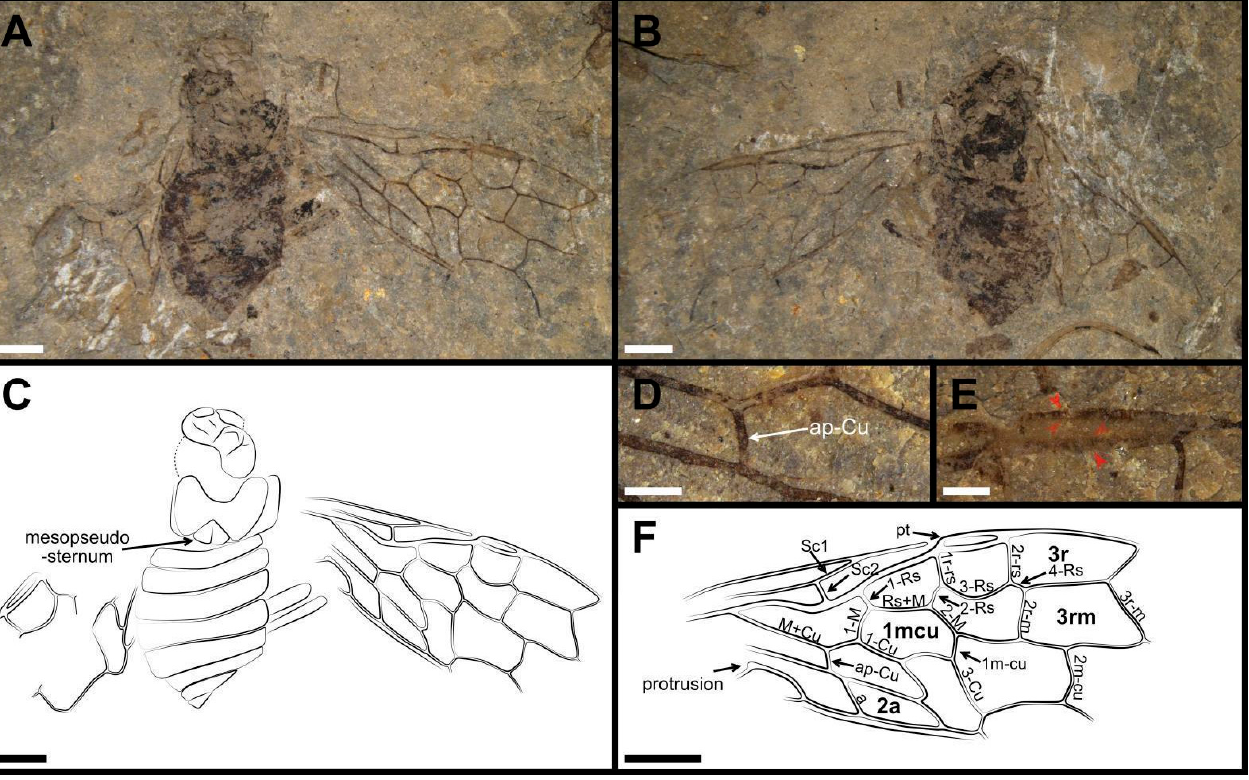
Figure 4. Dolicholyda confluens sp. nov., Holotype, (CNU-HYM-ND2022107p/c), sex unknown. ( A ), ventral view. ( B ), dorsal view. ( C ), line drawing of ventral view. ( D ), ap-Cu in forewing. ( E ), pterostigma. ( F ), line drawing of forewing. Arrows in red mean the venations here are highlighted. Cell names are in bold. Scale bars: 2 mm in ( A – C , F ); 0.5 mm in ( D , E